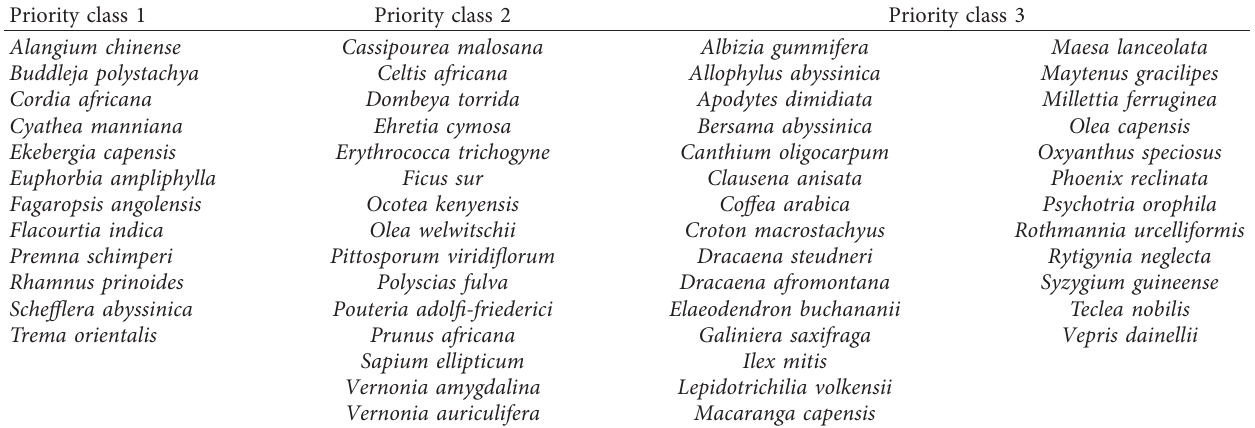
Table 4: Species conservation priority